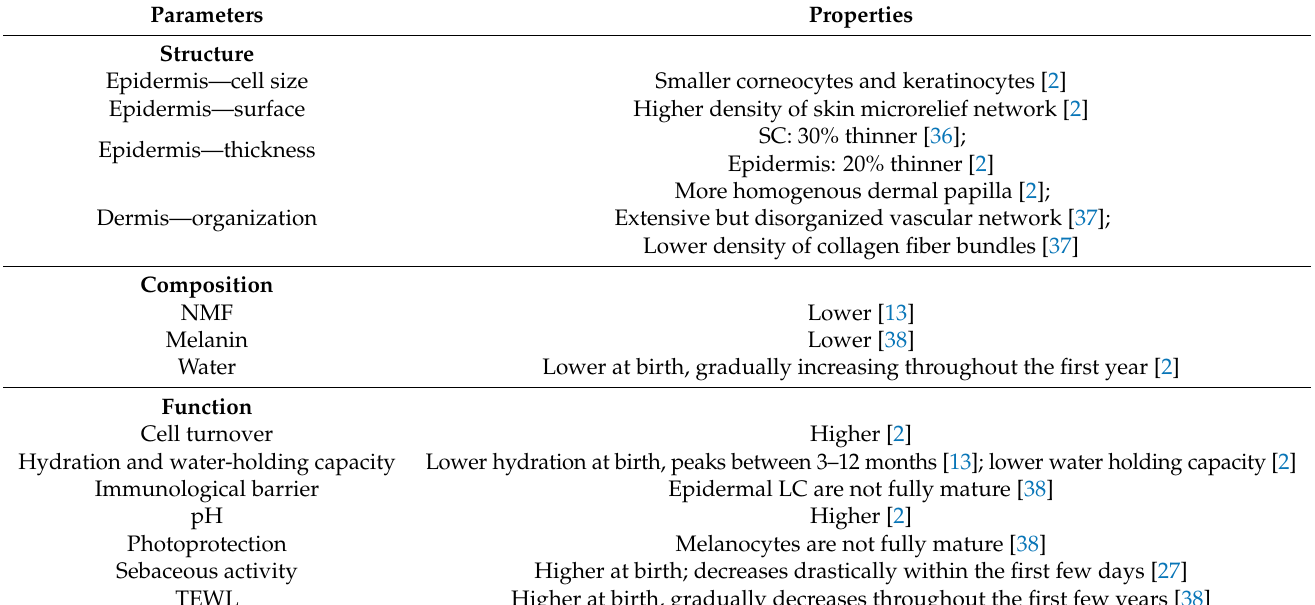
Table 2. Skin physiology of healthy infants in comparison to